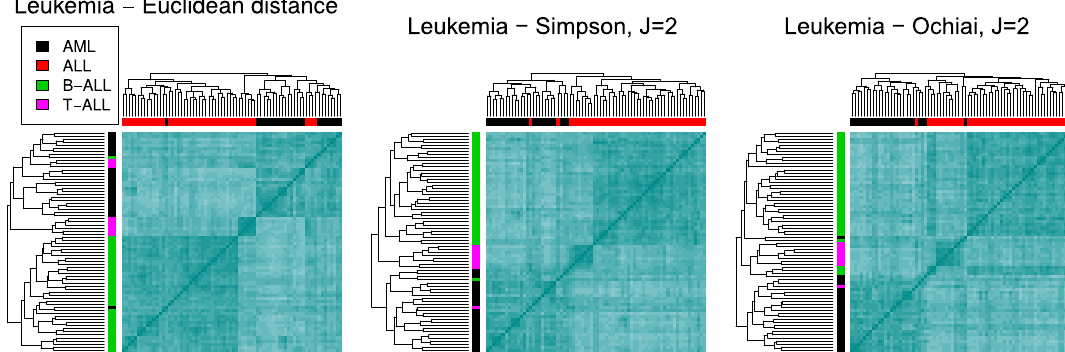
Figure 7. Clustering the leukemia data set. Dendrograms and heatmaps for the leukemia data set, using the Euclidean distance (left), the Simpson index (middle) and the Ochiai index (right), for J = 2 . The colour labels in the columns and the rows correspond to the 2-class and 3-class scenarios,